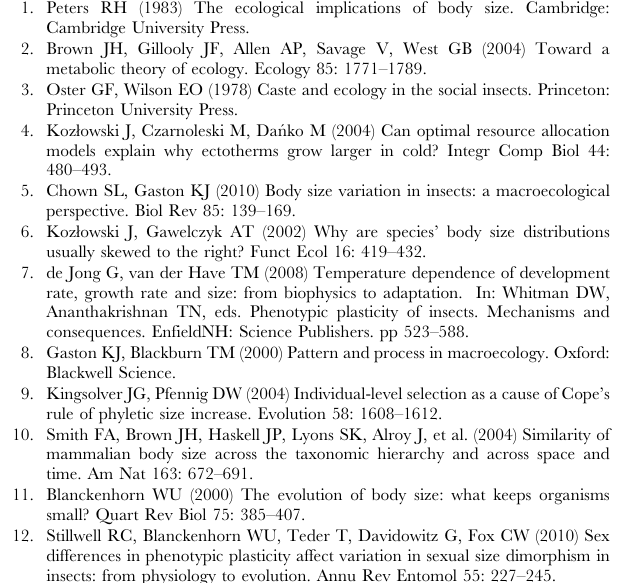
Table S2 Outcome of the tests for the deviation from normality (Shapiro-Wilks W statistic) and the degree of skewness ( g 1 ) and kurtosis ( g 2 ) for the (a) untransformed body mass (mg) and (b) log transformed body mass frequency distributions of the males and females. Table S3 Outcome of the tests for the deviation from normality (Shapiro-Wilks W statistic) and the degree of skewness ( g 1 ) for the (a) untransformed linear (mm) and (b) log transformed linear frequency distributions of the males and females. * P , 0.05, ** P , 0.01, *** P , 0.001, ns= not significant, after correction for the false discovery rate. Table S4 Intraspecific body size frequency distribution (IaBSFD) data for insects, indicating whether one or more figures of the data are provided, the outcome of tests for skewness, or normality if former not available, and whether additional data on variation associated with age, sex, time or space are